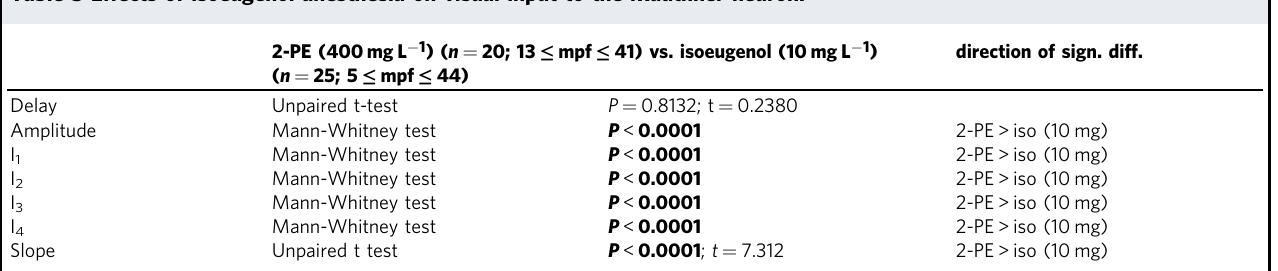
Table 3 Effects of isoeugenol anesthesia on visual input to the Mauthner neuron.